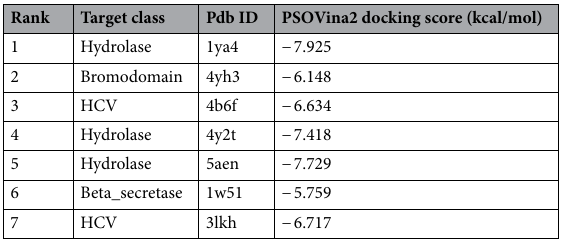
Table 4. Predicted putative tamoxifen targets retrieved from LigTMap.